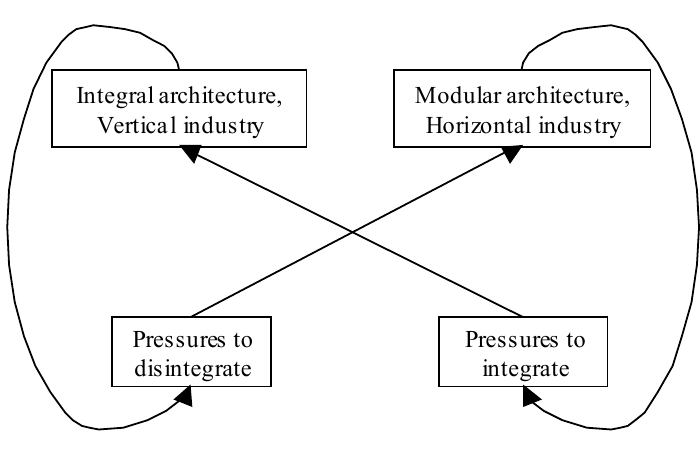
Figure 3. Continuous shift of the